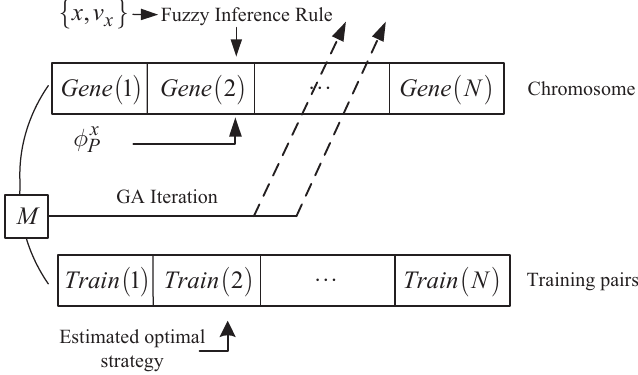
Figure 4. The diagram of the pre-training